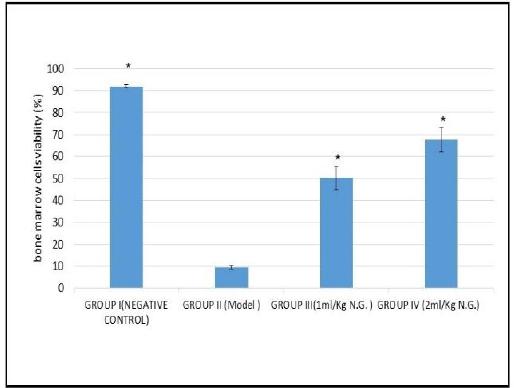
Figure 2.Bar chart showing bone marrow cells viability test in various experimental mice